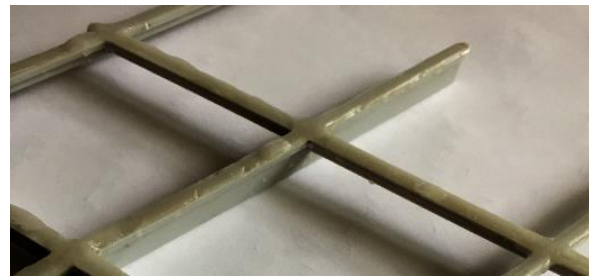
Fig. 12. Grid fill with hydrophobic surface .